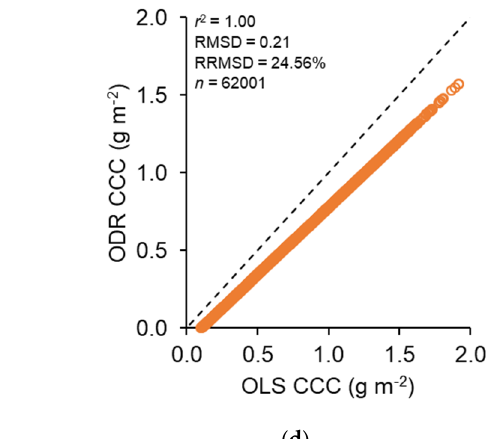
( right ) for the Las Tiesas–Barrax ( a , b ) and Wytham Woods ( c , d ) campaigns. The dashed line represents a 1:1 relationship.